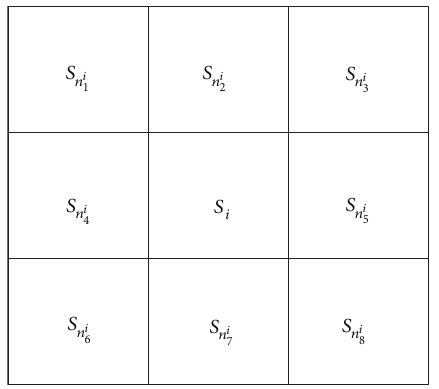
Figure 2: Moore neighborhood where each cell has eight nearest